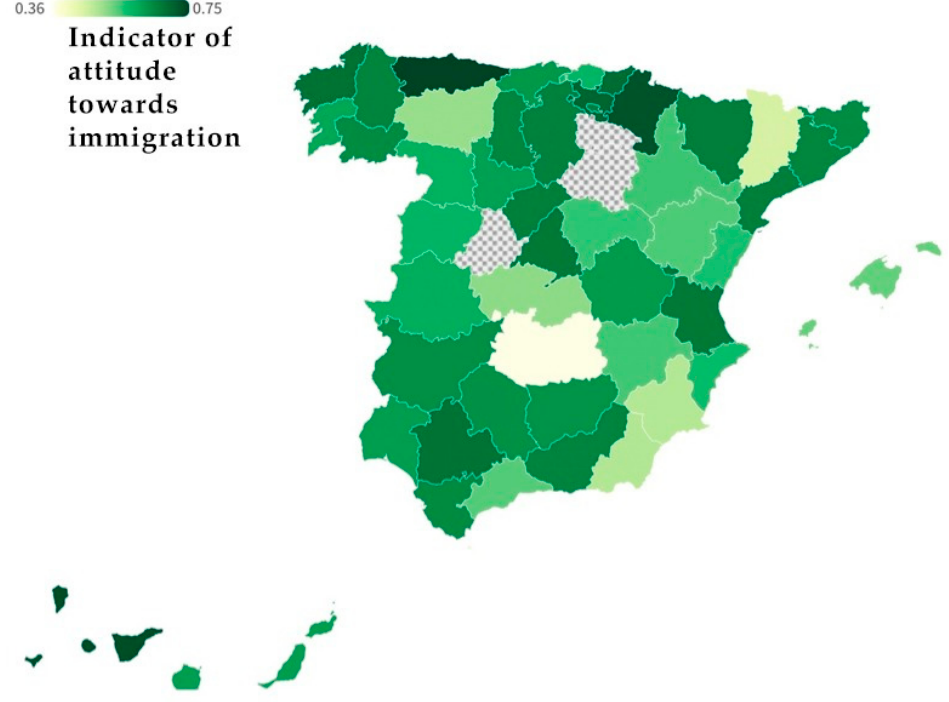
Figure 2. Average acceptance towards immigration in Spain. Own elaboration, using CIS data (2017).